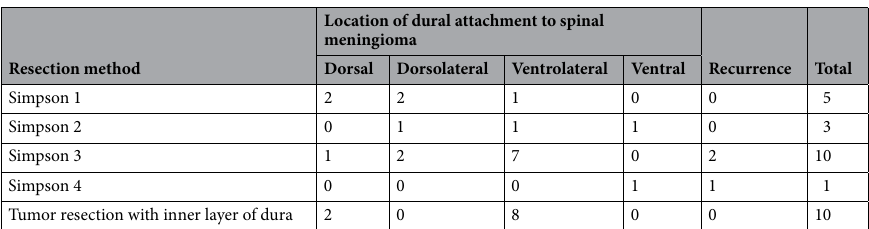
Table 2. Resection method. Values indicate number of patients.